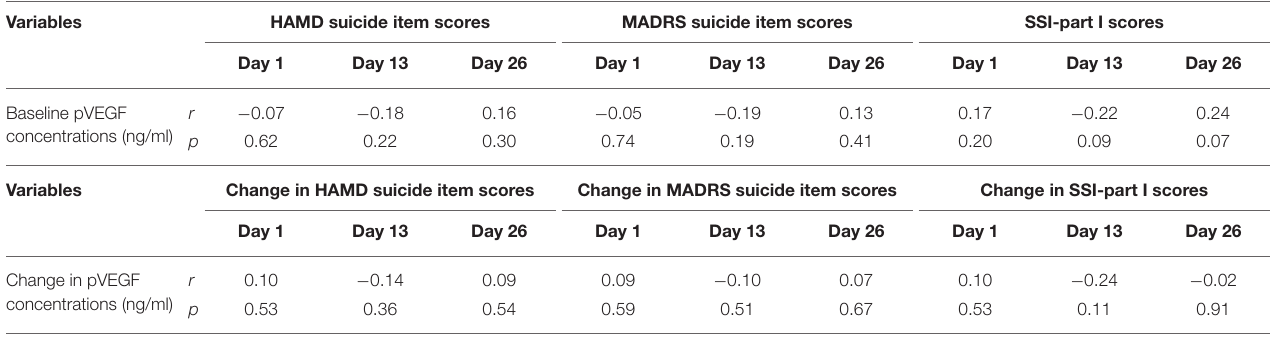
Change in pVEGF concentrations (ng/ml)